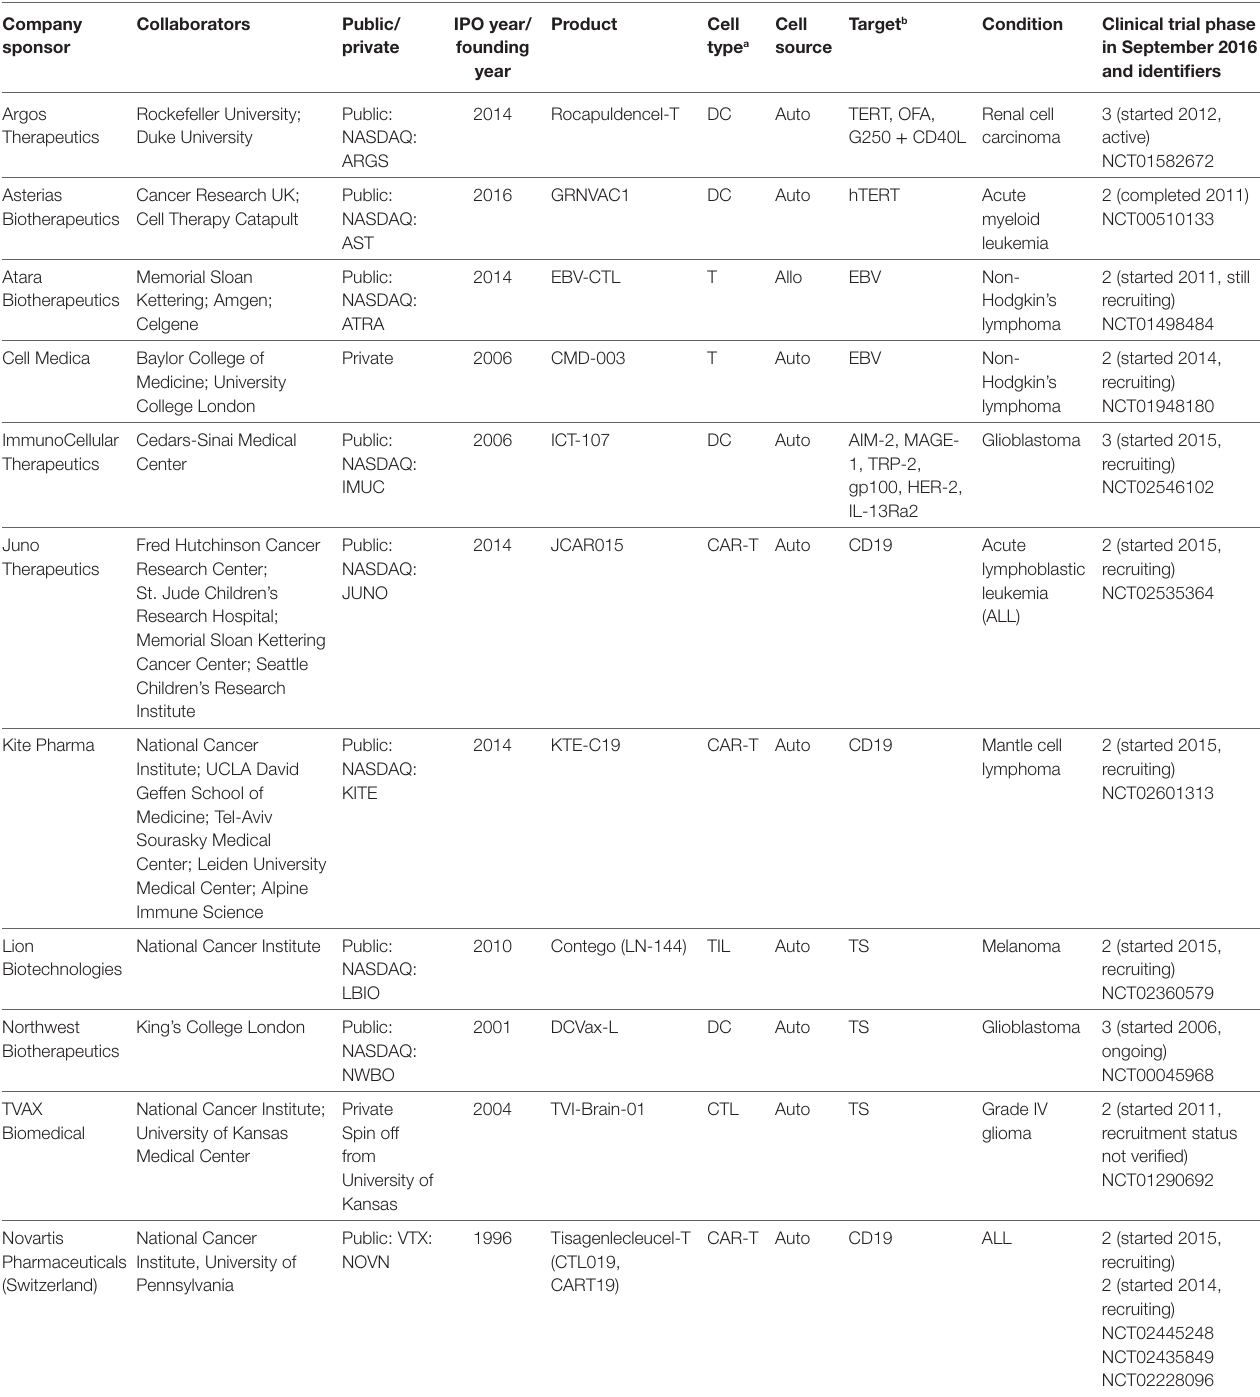
TABLe 1 | Public–private collaborative efforts in the US of cancer cellular immunotherapy in Phase II and III clinical trials. Company